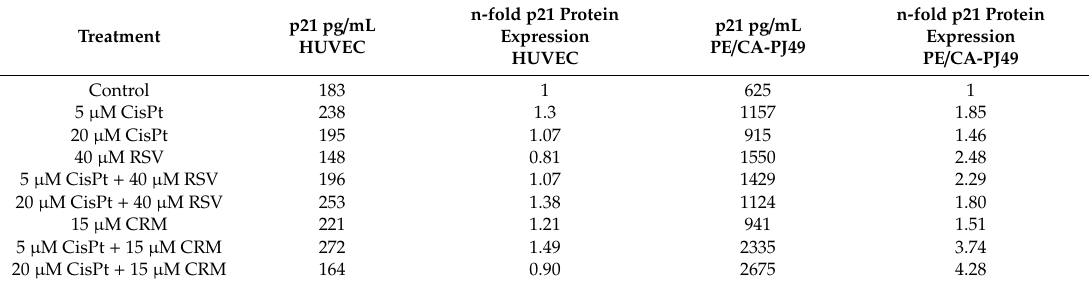
Table 4. The e ff ects of CisPt, RSV, CRM treatment applied alone or in combination for 24 h on the level of p21 protein expression (n-fold p21protein expression) in normal cell line-Huvec and in tumor cell line-PE / CA-PJ49. The n-fold p21expression was calculated using the formula: n-fold p21expression = p21 pg / mL treatment / p21 pg / mL